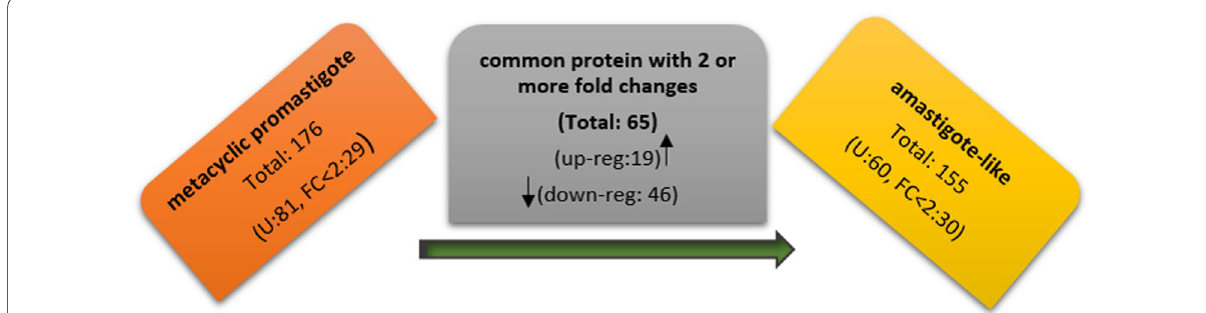
Fig. 1 The number of protein profile, differential and uniquely protein expression between metacyclic promastigotes and axenic amastigotes of Iranian L. tropica isolates (U: uniquely expression; FC: Fold Change; up‑reg: up‑regulated; down‑reg: